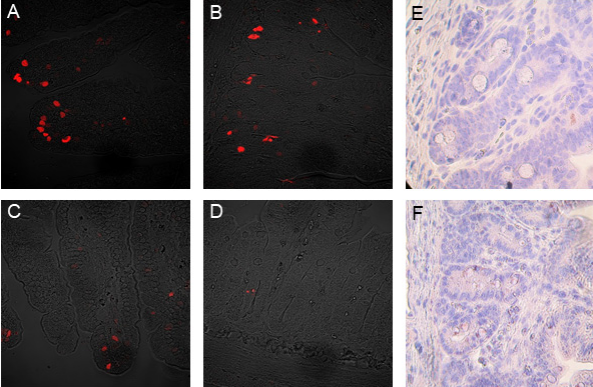
Figure 3. Representative microscopic images of the middle jejunum mucosa in 10-day-old control ( C ) and sodium-butyrate-treated piglets ( B ) (at a dose of 0.3%), with apoptotic cells (red) visualized using a TUNEL assay. Intestinal villi ( A ) and crypts ( B ) in piglets from the control group (group C). Intestinal villi ( C ) and crypts ( D ) in piglets from the sodium butyrate treated group (group B). The tissue structure was visualized using Nomarski contrast in a confocal microscope (LSM Pascal, Zeiss, Germany, magnification: 400 × ). Ki67-positive epithelial cells (3,3 (cid:48) -diaminobenzidine staining, brown) in crypts counterstained with hematoxylin in blue in animals from the control group (group C) ( E ) and from the sodium-butyrate-treated group (group B) ( F ). Light microscope (Axioskop 40, Zeiss, Germany), magnification: 400 ×